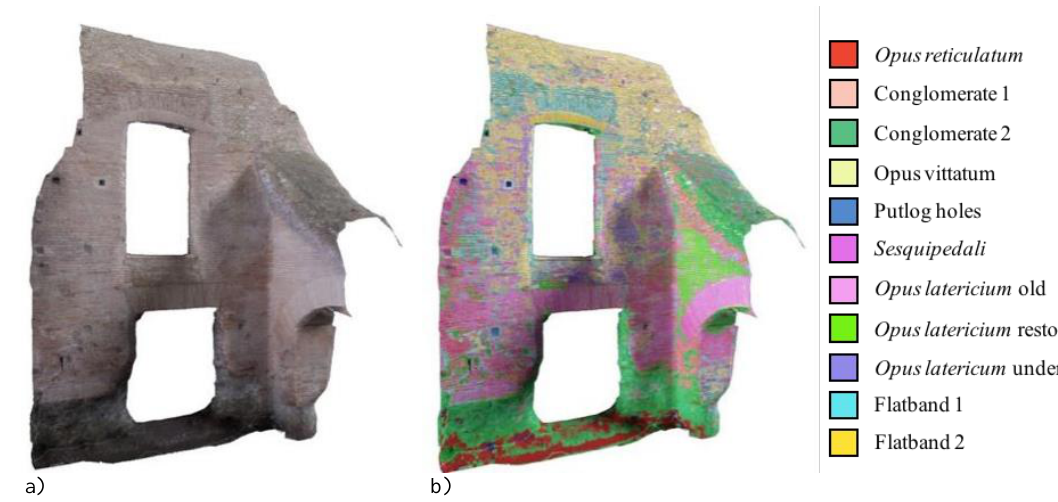
Figure 8: Original and segmented 3D model of a portion of Roman Cavea in the Circus Maximus in Rome (Italy).